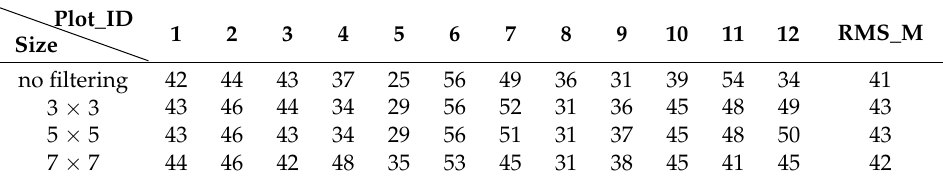
Table 3. Matching results of plot 10 with density threshold T d of 0, 1.2, 1.4, and 1.6